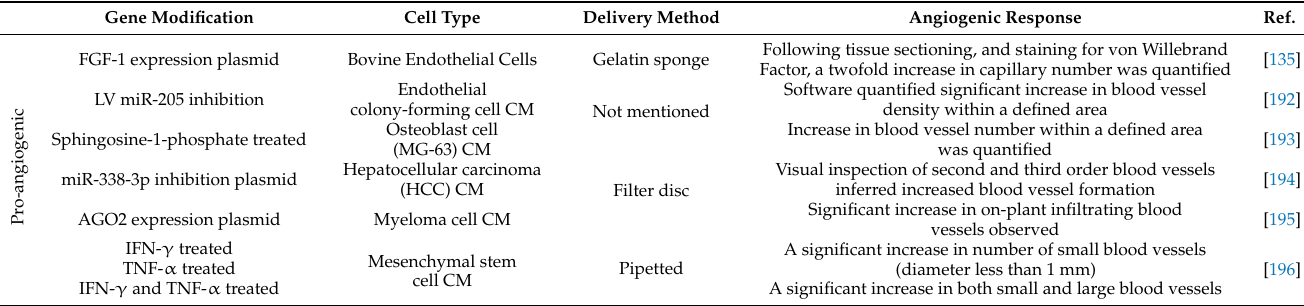
Table 5. Examples of treated and gene modified cells or conditioned media (CM) applied to CAM